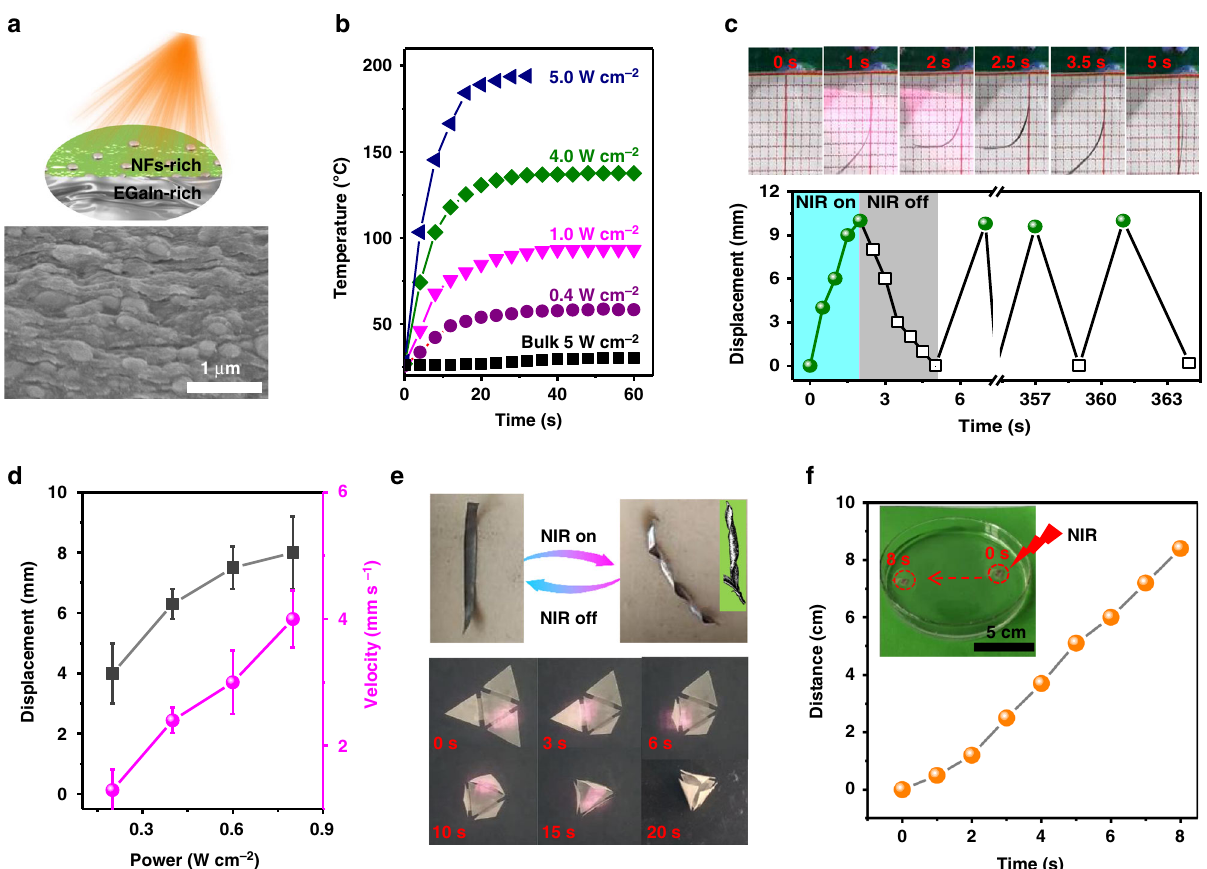
Fig. 4 Photo-driven actuating behaviour of Janus fi lm. a Schematic illustration and SEM image of EGaIn droplets in CNFs-rich layer. b Photo-thermal effect at different NIR power densities. Rectangular fi lm of 20 × 10mm 2 ; EGaIn/CNFs layer thickness: 9/10 μ m/ μ m. NIR wavelength: 808 nm. Bulk EGaIn was used as the control. c Visual observation (Top) and repeatability (Bottom) of actuating behaviour under NIR irradiation. Power density of NIR: 0.8 W cm − 2 . d Displacement and actuating speed at different NIR power densities. e Photo-driven self-twisting (Top) and origami (Bottom). The inset (top right) shows twisted Vigna Radiata pods. f Photo-driving fl oating displacement in water. Energy density of radiation: 0.8 W cm −